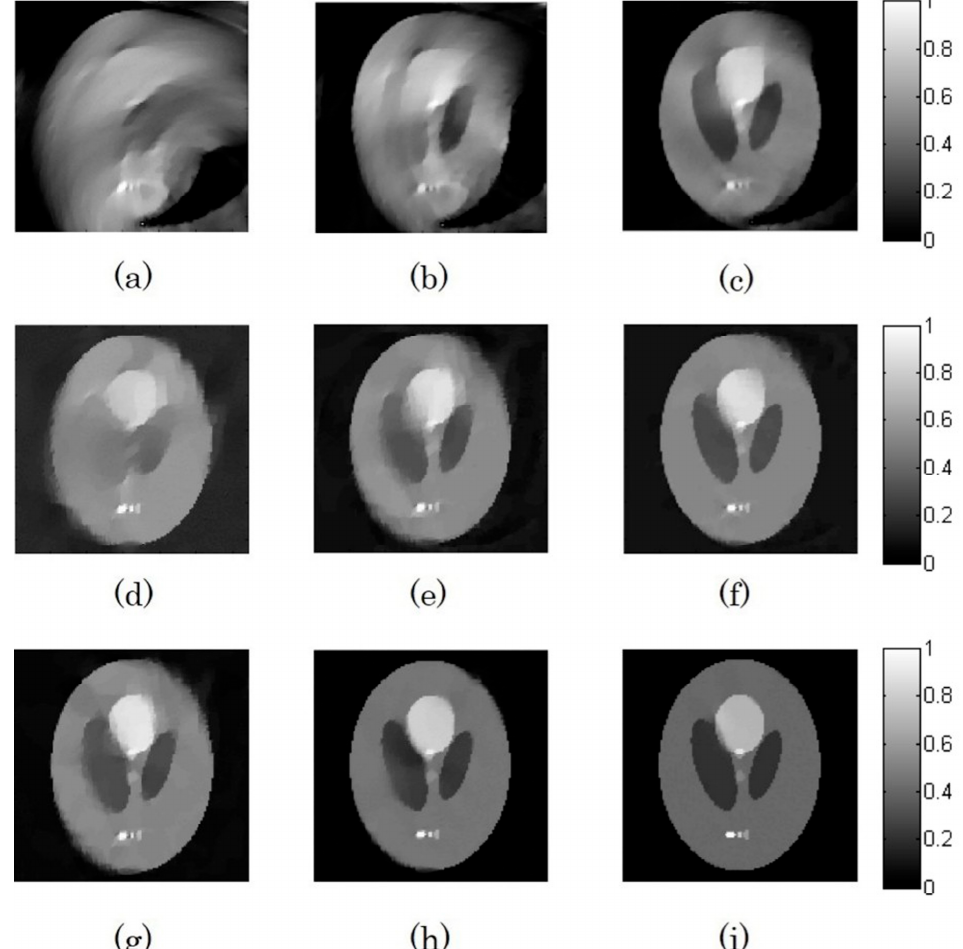
Figure 8. The reconstructed images from the limited-angle circular scanning by the TV-GD, TV-VB and TV-GPEF algorithms: the first row refers to the results of the TV-GD ( a – c ); the second row refers to the results of the TV-VB ( d – f ); and the third row refers to the results of the TV-GPEF ( g – i ). The first to third columns refer to the results from: 60-views ( a , d , g ); 90-views ( b , e , h ); and 120-views ( c , f , i ) sampling, respectively.